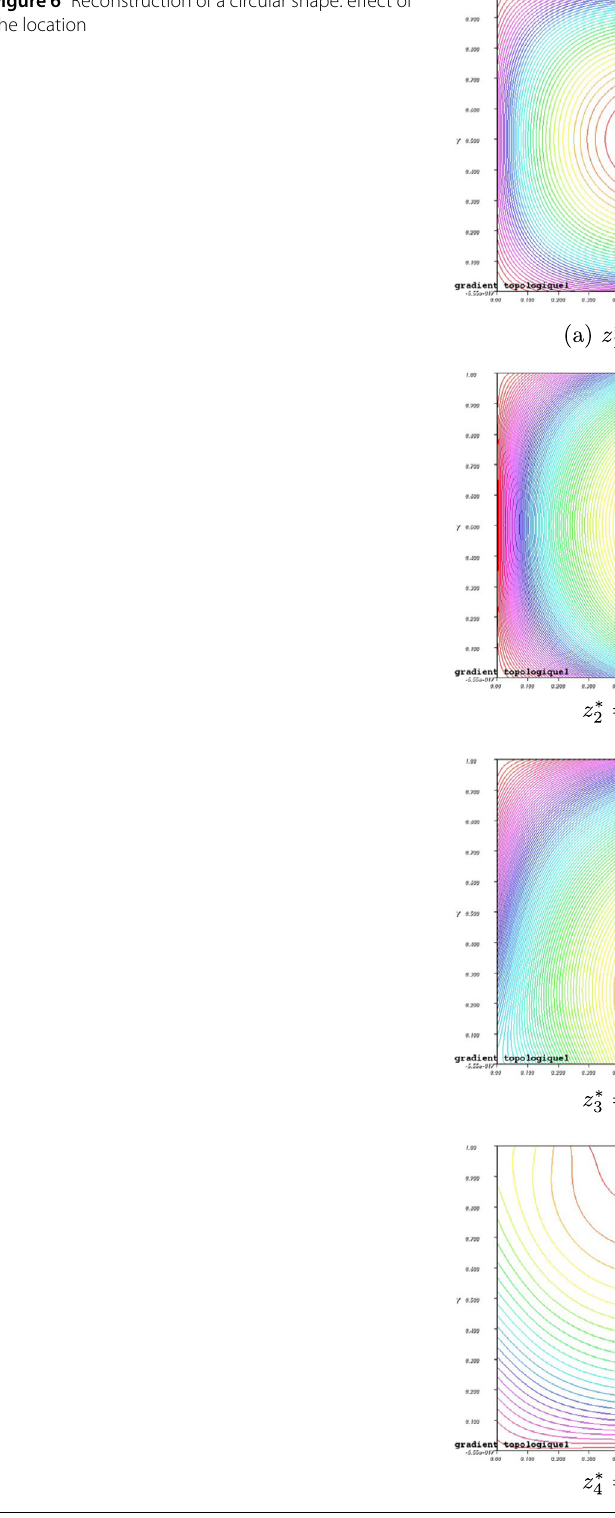
Figure 6 Reconstruction of a circular shape: effect of the